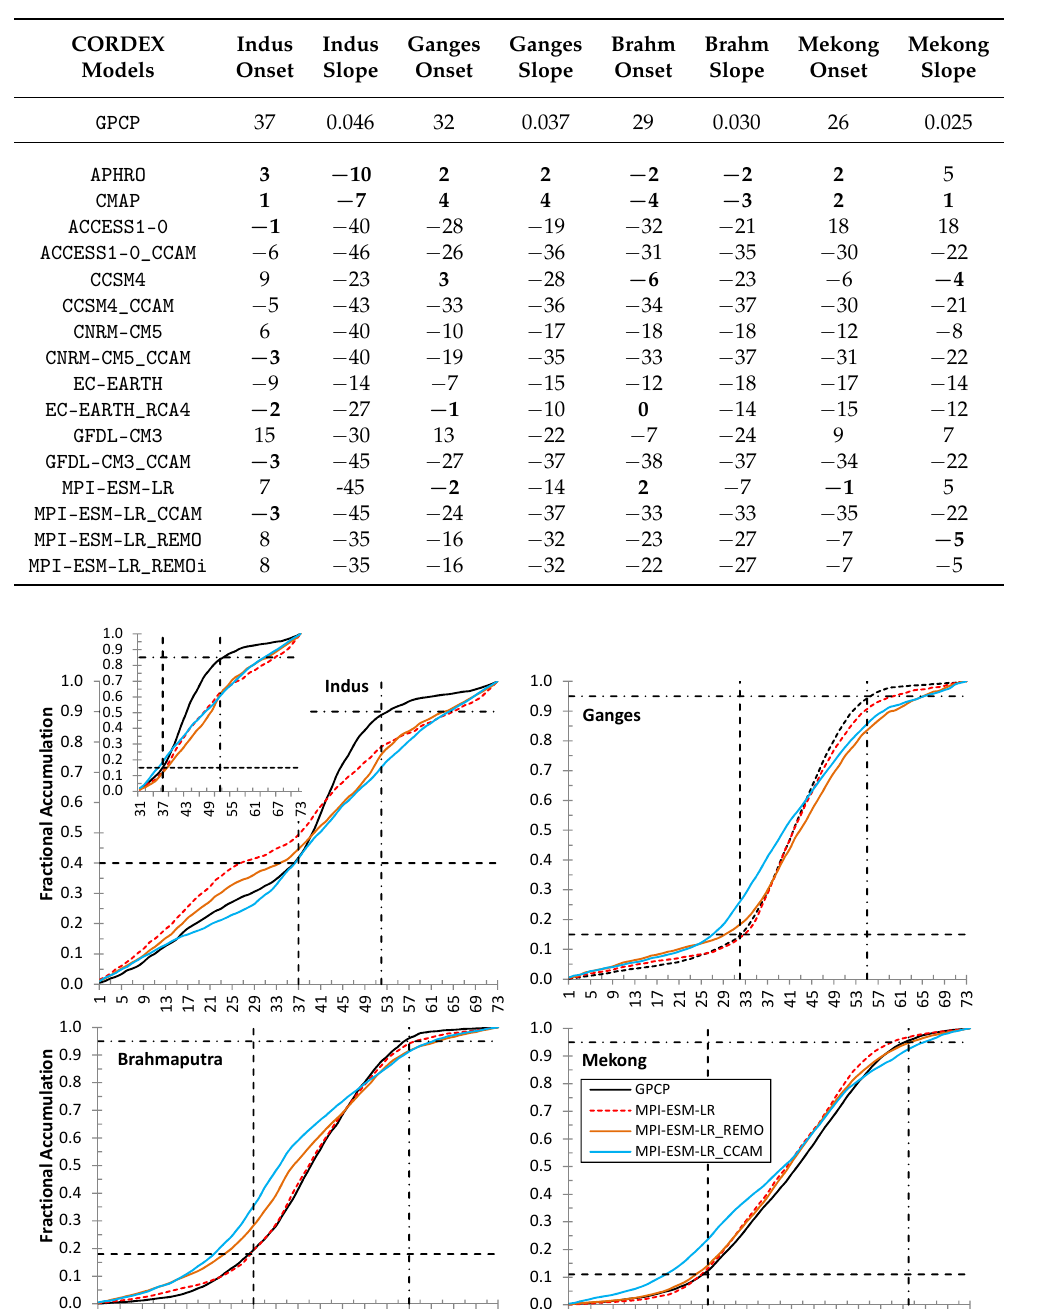
Table 2. First row: Observed onset pentads and RFA slopes from GPCP. Other rows: Offset of onset (in days) and RFA slope (in %) relative to GPCP. Note: Negative values indicate early onset or underestimated RFA slopes and vice versa. Bold values indicate statistically insignificant difference between the observed and the simulated climatological means.